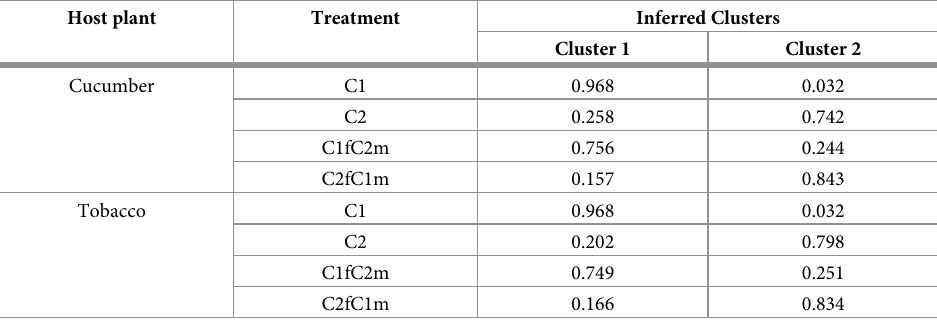
Table 2. The proportion of membership according to Bayesian clustering method for two clusters in each treat- ment group of B . tabaci (n = 20). Host